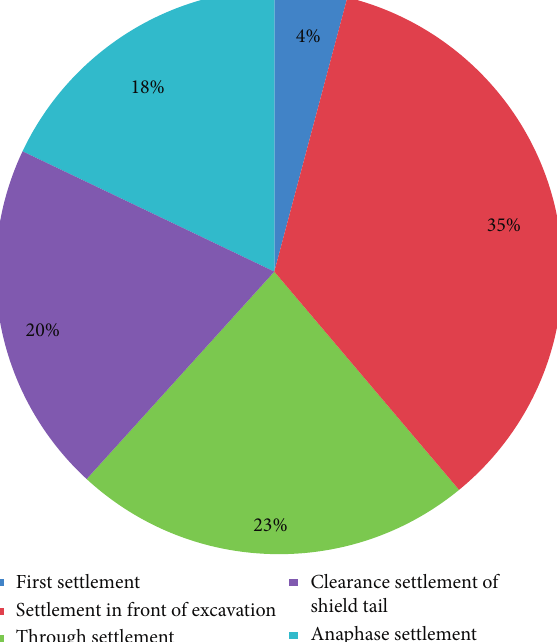
Figure 14: Settlement scale map of cross section 1 (test section).